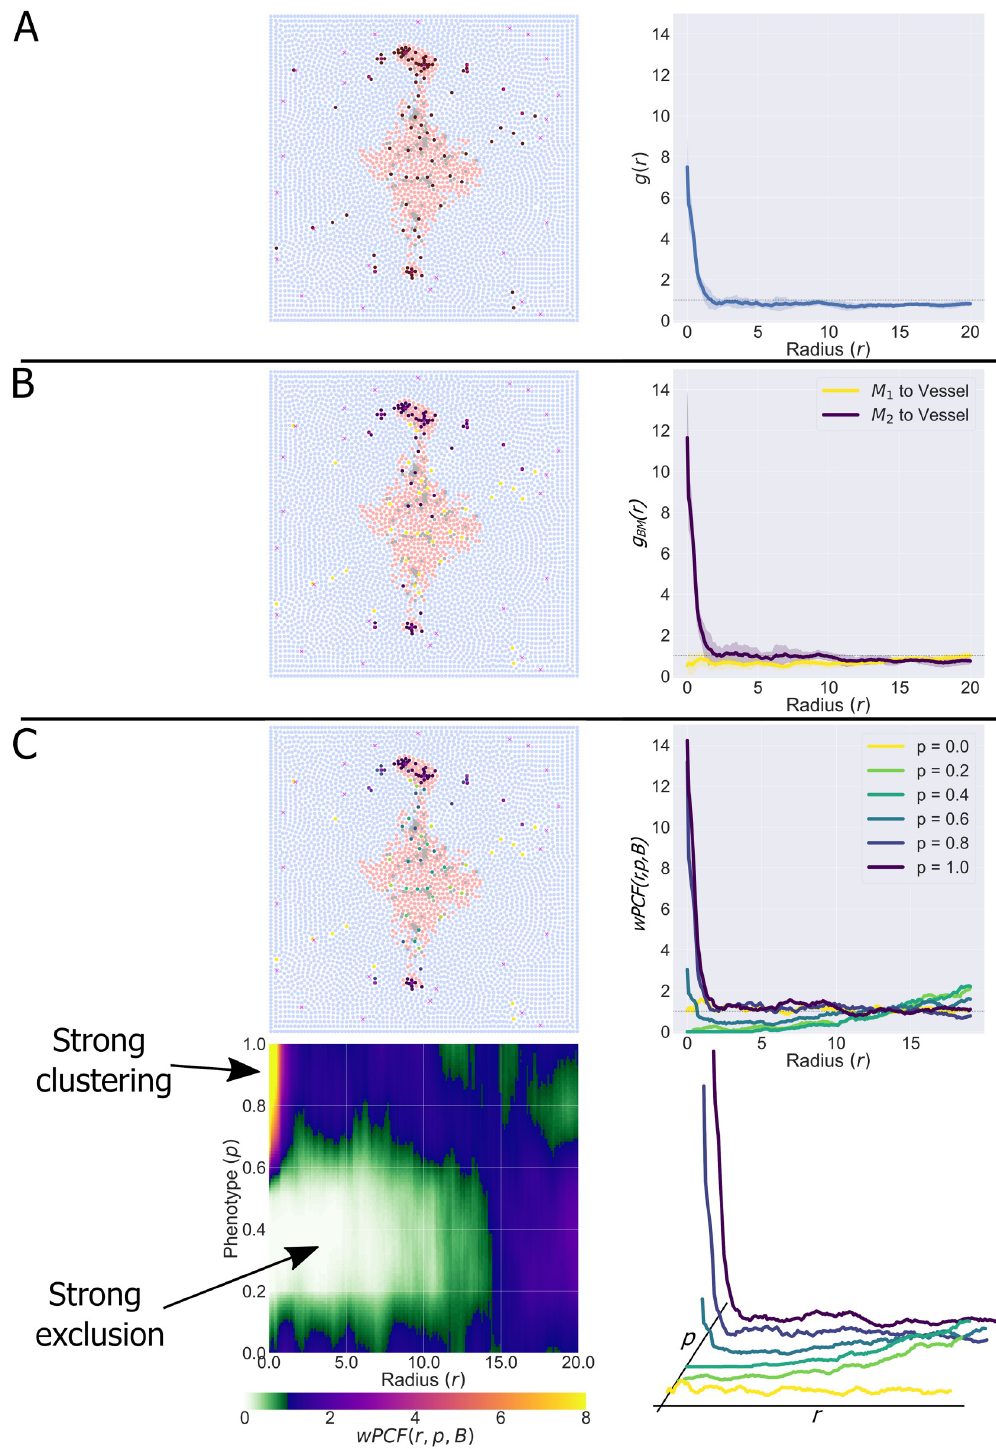
Fig 5. wPCF shows how macrophage phenotype and spatial distribution are related. A: Treating macrophages as a single population shows clustering between macrophages and tumour cells in the cross-PCF. B: Defining two populations of macrophages (M 1 , with p � 0.5, or M 2 with p > 0.5) shows differences in spatial localisation: M 1 macrophages are randomly spread through the domain, while M 2 macrophages are clustered around blood vessels. C: Using the full phenotype spectrum reveals three macrophage subpopulations, which are clearly visible in the wPCF. Macrophages with p � 0 have no